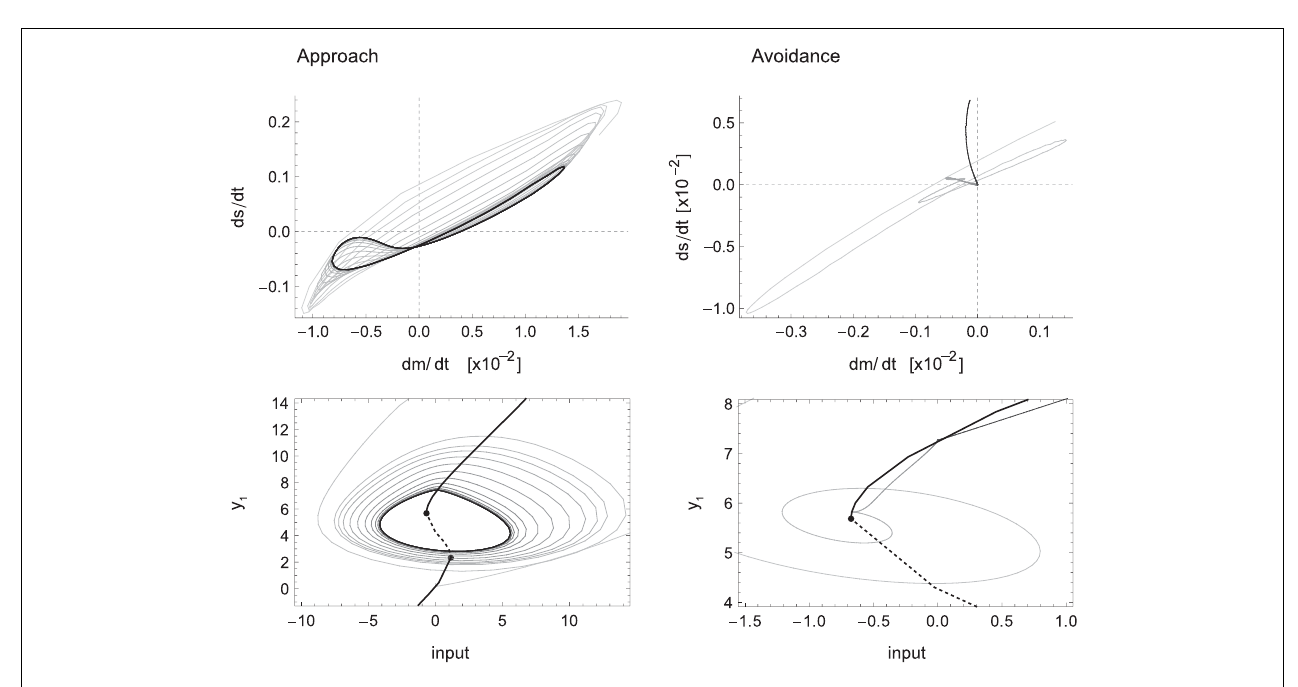
diagram, i.e., in coordinates of sensory input and the hidden neuron’s steady-state activation y 1 .The positions of the attractors, i.e., the states to which the system would settle in the long term, are indicated by solid lines emanating from the bifurcation points (filled circles). Note that in the case of approach, the system oscillates back and forth between the two attractors, while in the case of avoidance it gets eventually captured by one of